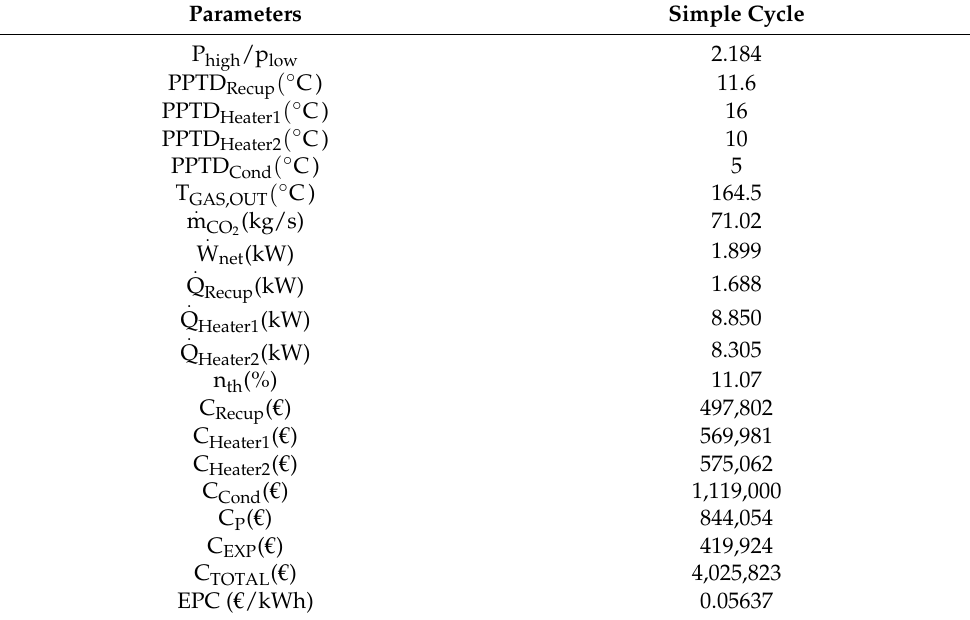
Table 7. Results from the optimization of the simple cycle with the genetic